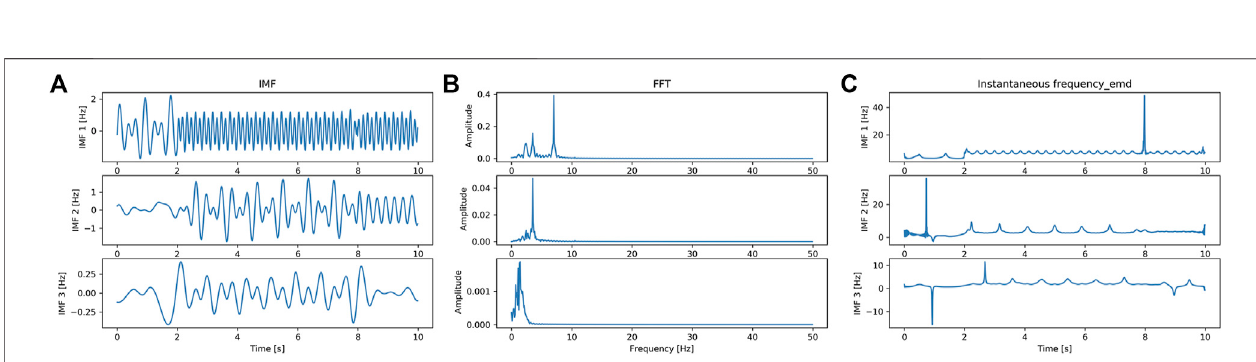
FIGURE 3 | EMD results for signal x 3 (t), (A) IMFs of x 3 (t); (B) FFT spectrum of each corresponding IMF; (C) Instantaneous frequency of each IMF.